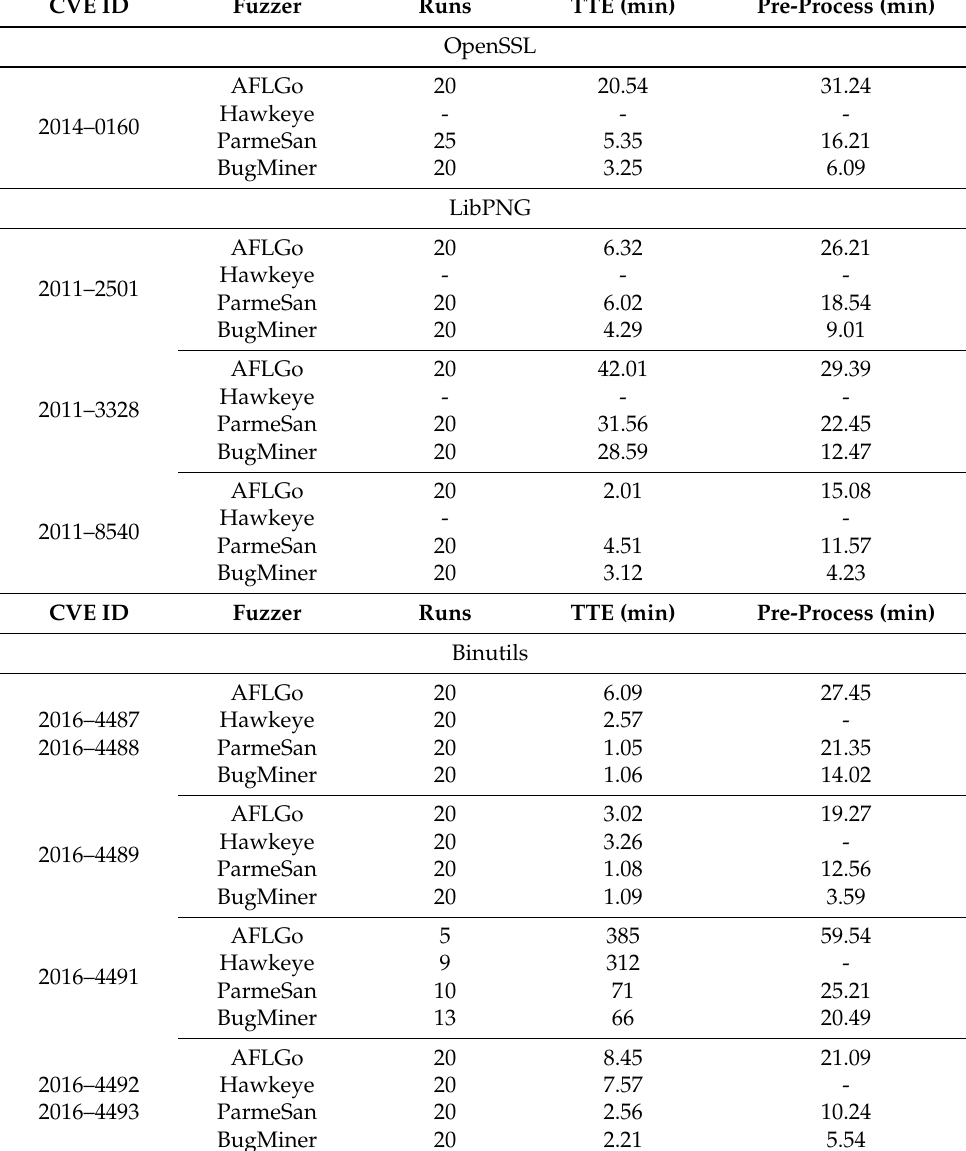
Table 5. Performance of BugMiner over directed fuzzers.